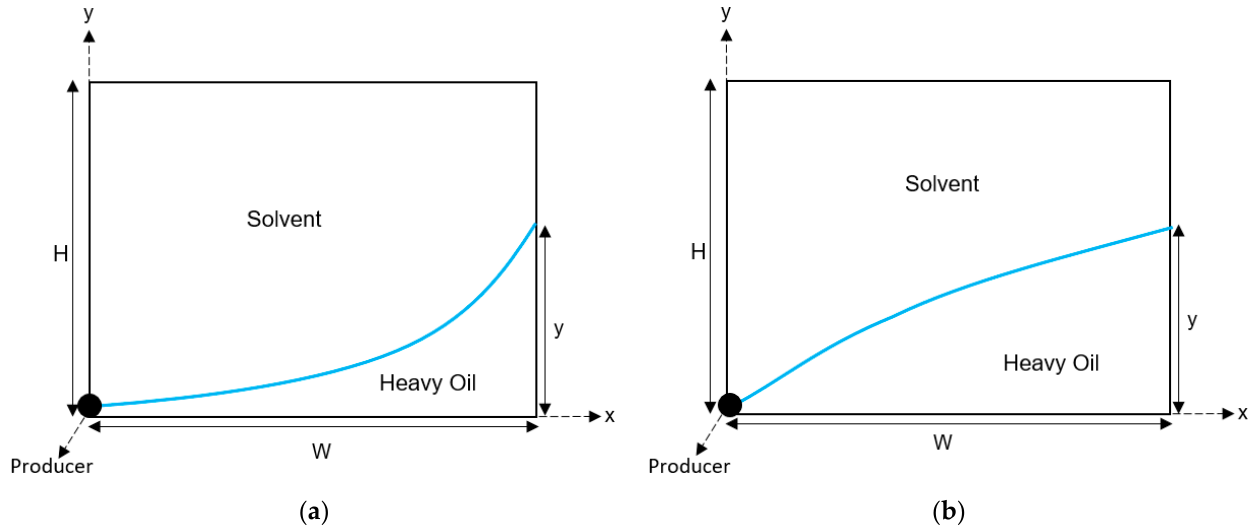
Figure 8. Solvent chamber area for one side of the physical model at the falling stage of the ( a ) concave case and ( b ) convex case.